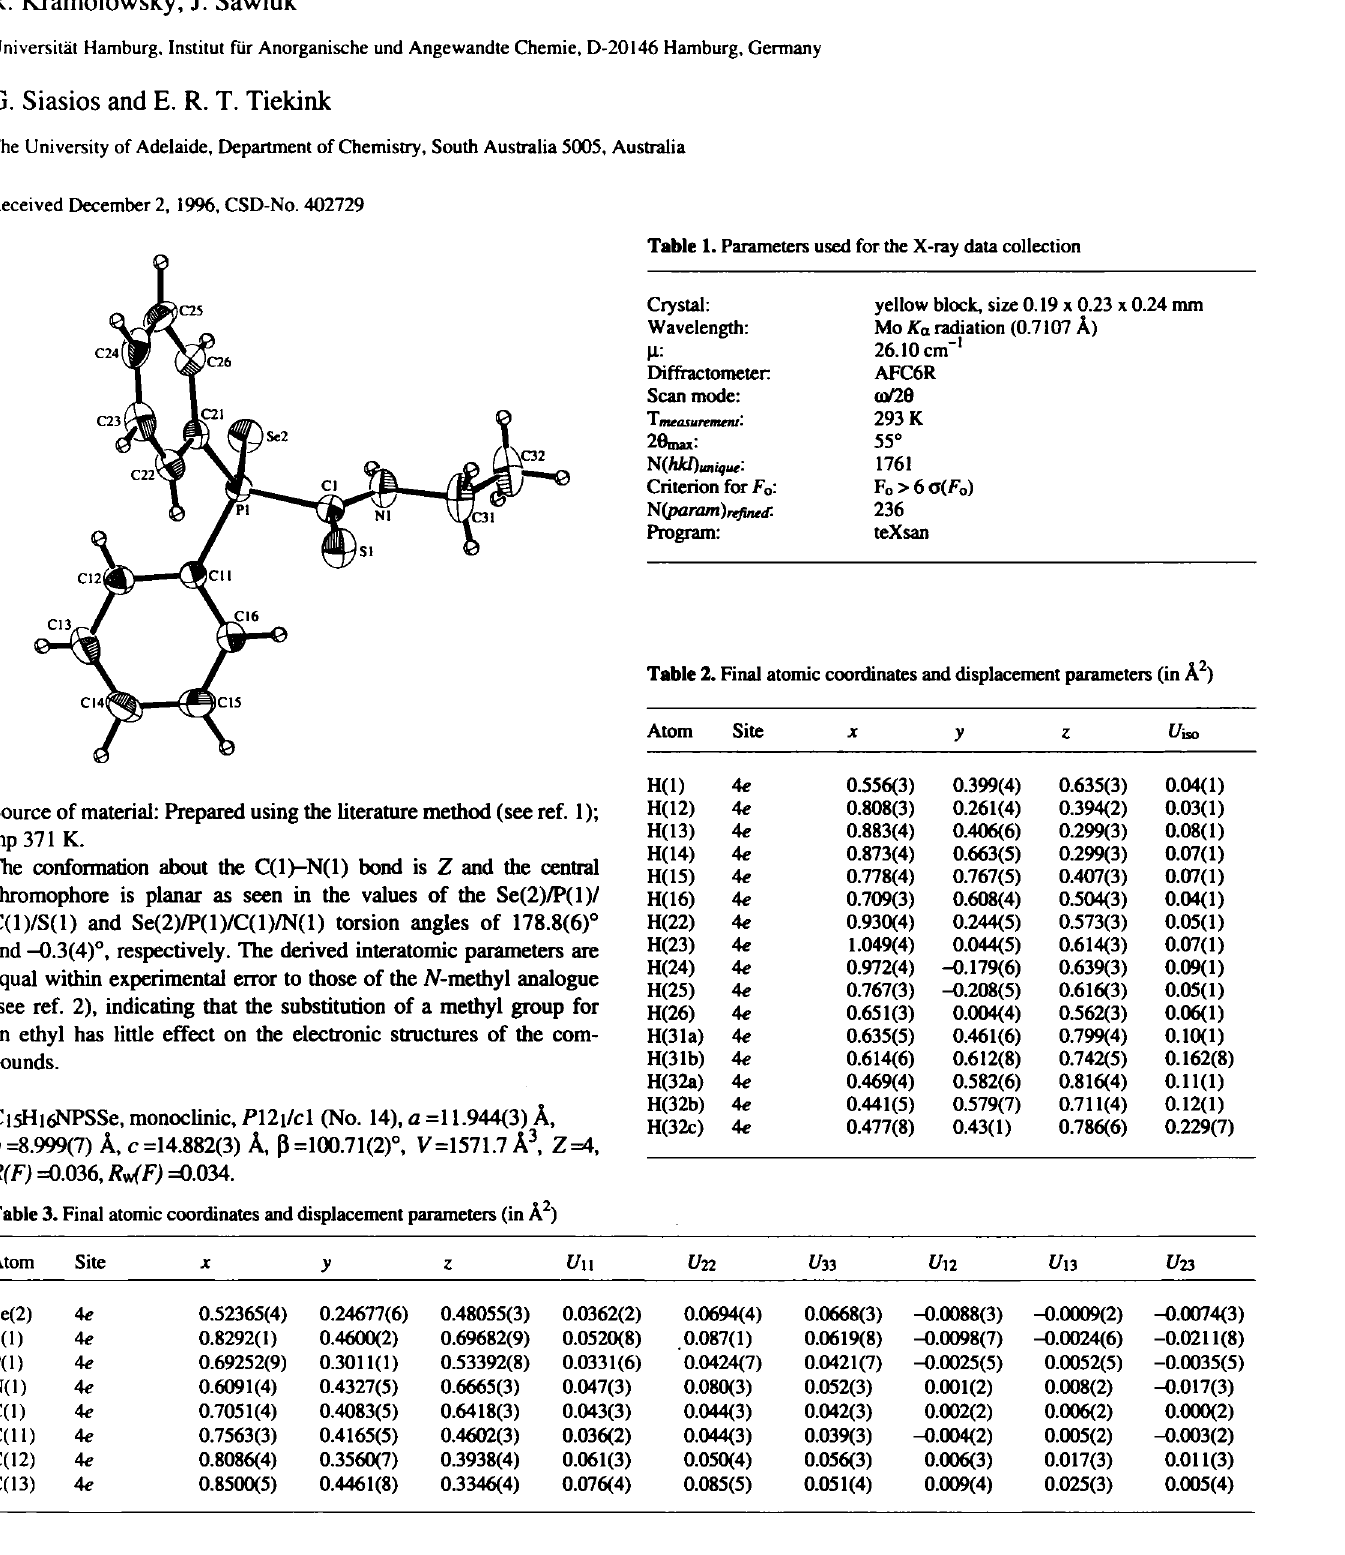
Table 3. Final atomic coordinates and displacement parameters (in Â 2 )